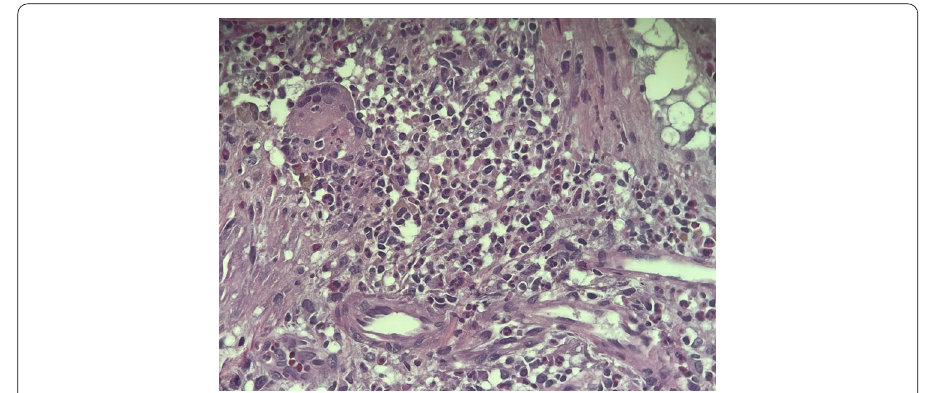
Fig. 4 Hematoxylin and eosin stain at 400 body-type giant cell